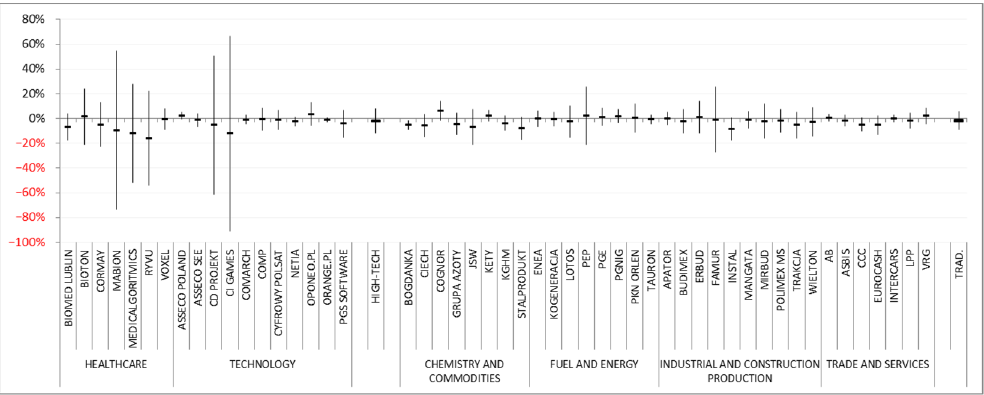
Figure 13. A typical area of variation in asset productivity in the surveyed enterprises. Source: own work.